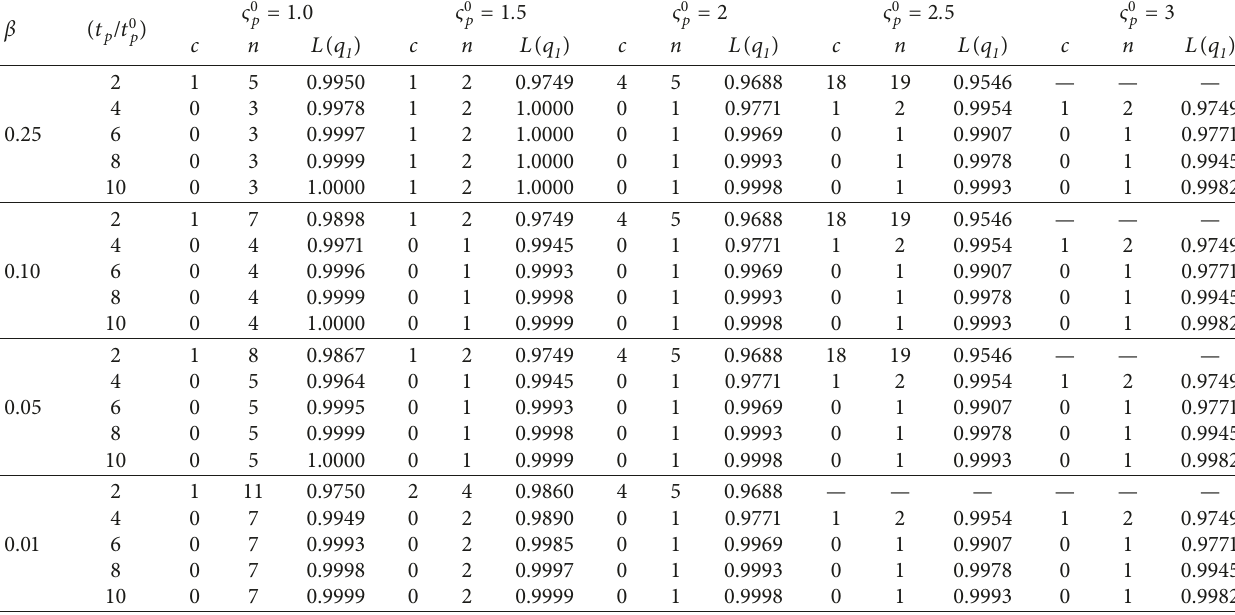
Table 5: The plan parameters and OC values for NGExp-Weibull distribution for φ � 0 . 0307 , δ � 5 . 59645, and k � 4 . 9906. ς 0 p � 1 . 0 ς 0 p � 1 . β ( t p / t 0 p )